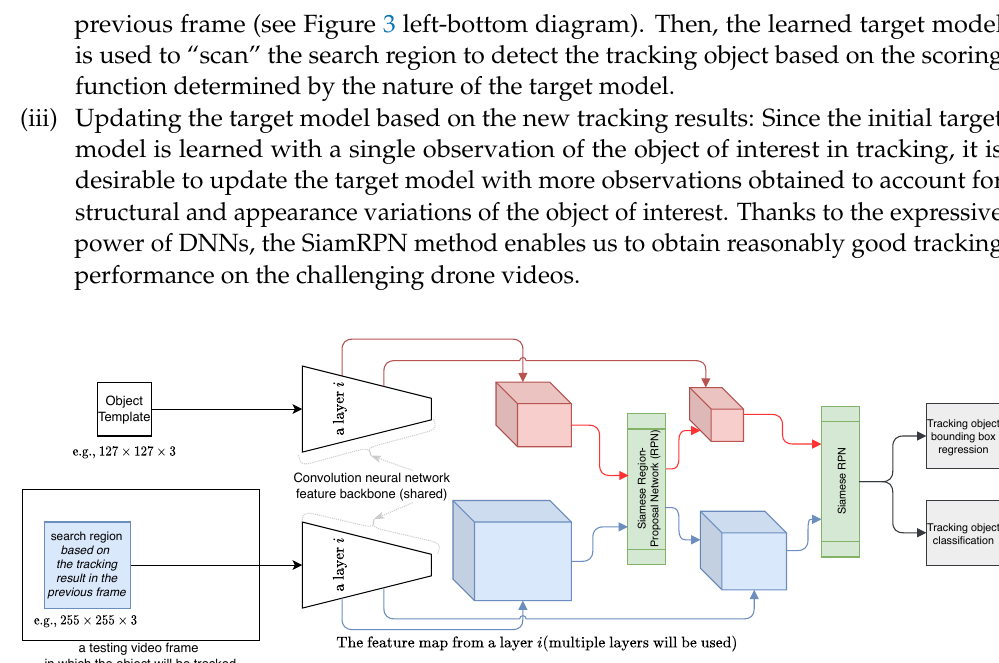
Figure 3. Illustration of the SiamRPN++ object tracking method, as edited from [33]. In tracking, given a target template (left-top) and search region (left-bottom), the network ouputs a dense prediction by fusion the outputs from multiple Siamese Region Proposal Networks (SiamRPNs). Each SiamRPN block is shown on